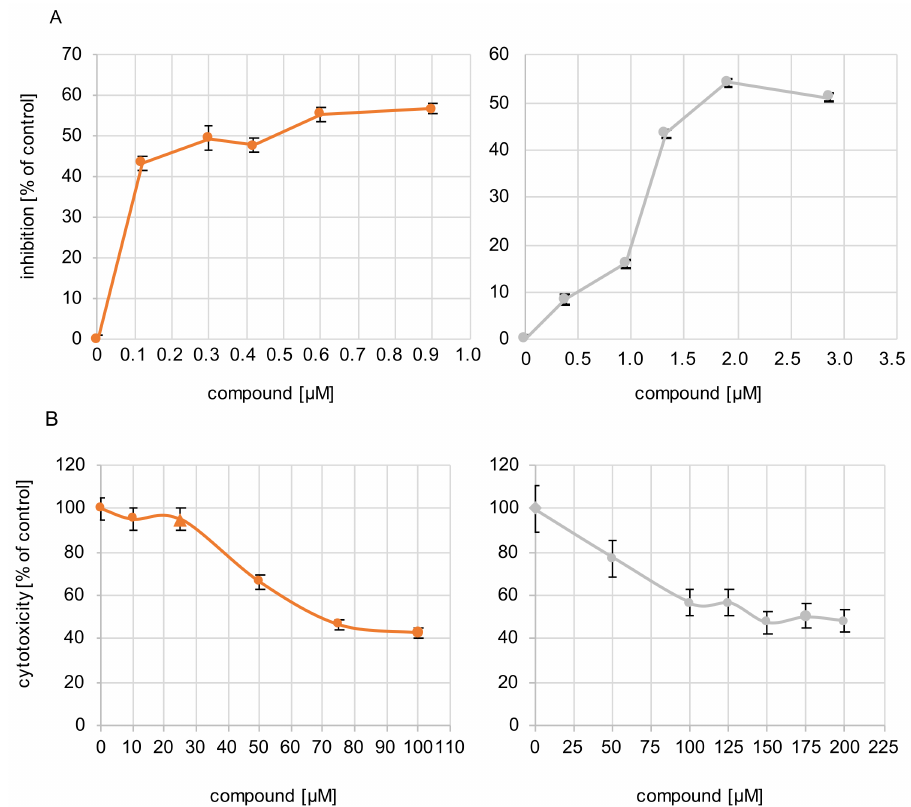
Figure 2. Antiviral activity of the compounds and their cytotoxicity. ( A ) Cells were infected with BCoV (MOI 0.00005) for 1 h. After infection, the inoculum was replaced by Avicel overlay containing increasing concentrations of sHA3 (orange) or sCS3 (grey). At 4 d p.i., plaque reduction assay was performed. Plaque reduction is indicated as inhibition as a percentage of PFU obtained in the absence of compounds. The mean 50% effective concentrations (EC 50 ) range from 0.2996 µ M for sHA3 and 1.7156 µ M for sCS3. Results were obtained from three independent experiments. Error bars represents the coefficient of variation. ( B ) Various concentrations of sHA3 or sCS3 ( µ M) were added to PT cells. At 24 h, XTT cell proliferation assay was performed. Values are represented as the percentage of untreated control cells. Data are mean values from three independent experiments. Error bars represent standard deviation.